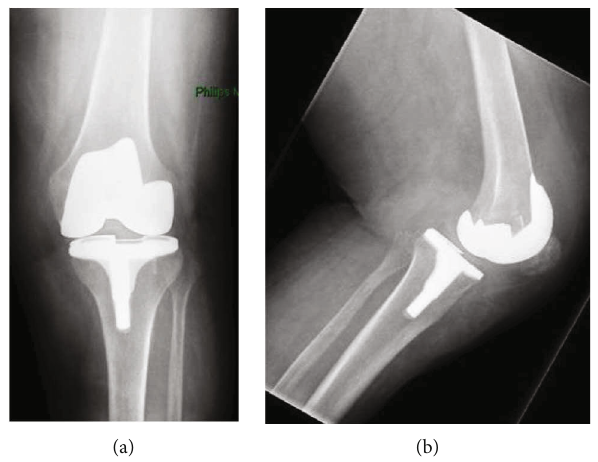
Figure 3: (a) Anteroposterior radiograph of case 3 at presentation in the emergency room. (b) Lateral radiograph of case 3 at presentation in the emergency room.